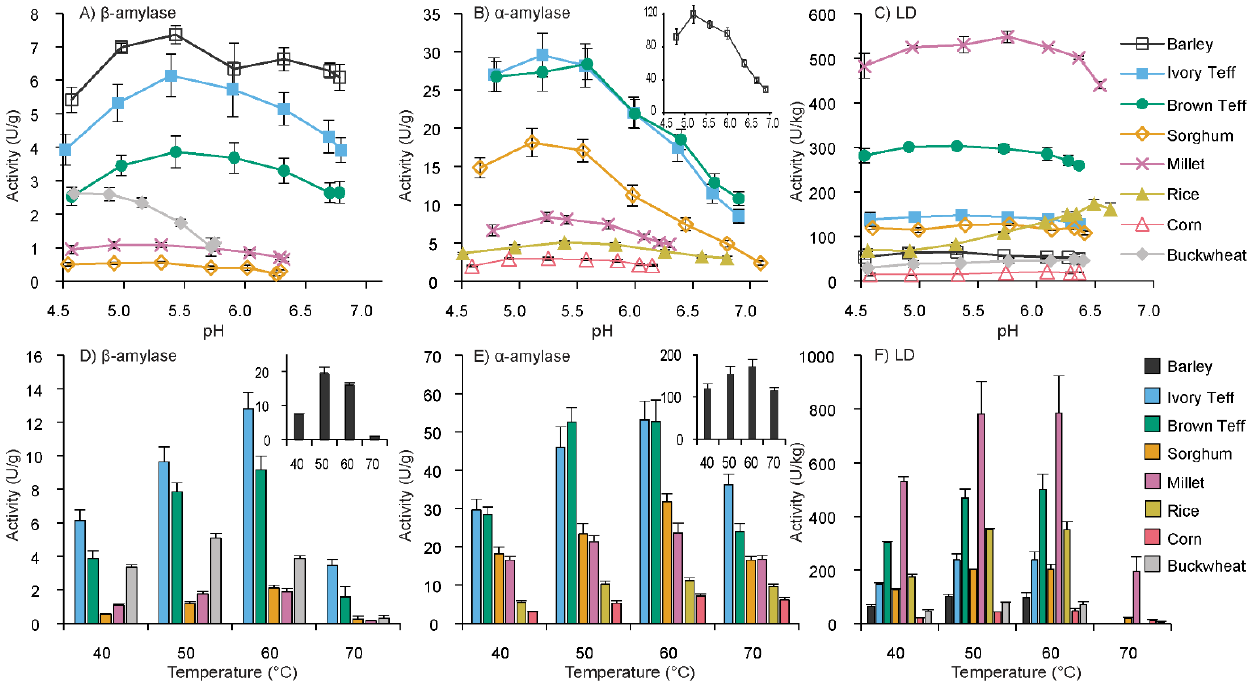
Figure 1. The effect of pH and temperature on the activities of β -amylase ( A , D ), α -amylase ( B , E ), and LD ( C , F ) in barley and GF malts as measured using the modified Betamyl-3, Ceralpha, and PullG6 methods described in Section 2.4. The insets in ( B , D , E ) are the observations of barley β -amylase and α -amylase as its high activity obscured the trends of the lower activity GF malts when plotted together. Data represent the means ( n = 3) ± standard deviations, and some error bars are within the data points.